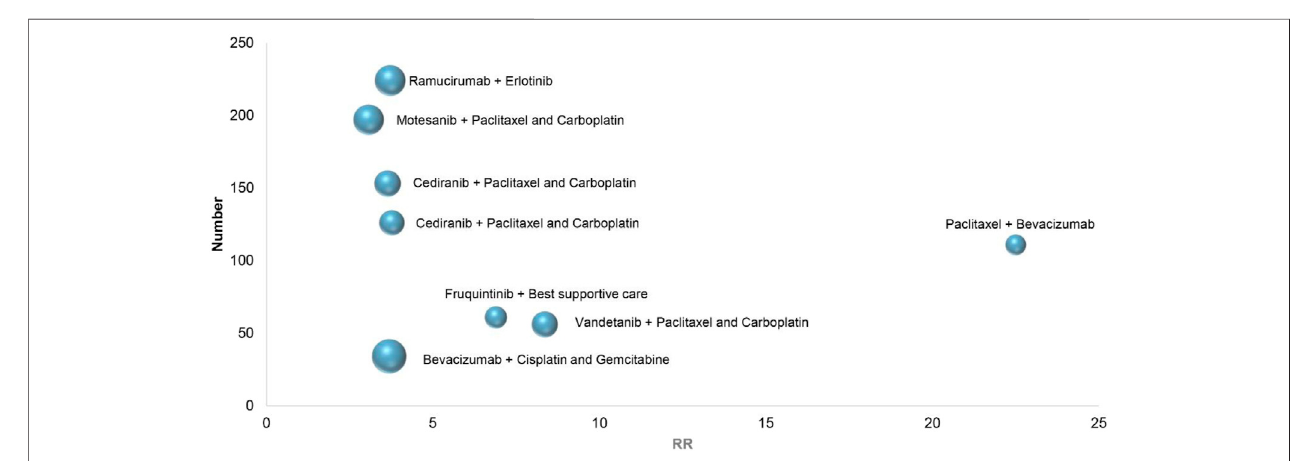
FIGURE 4 | Bubble chart: Non-small cell lung cancer